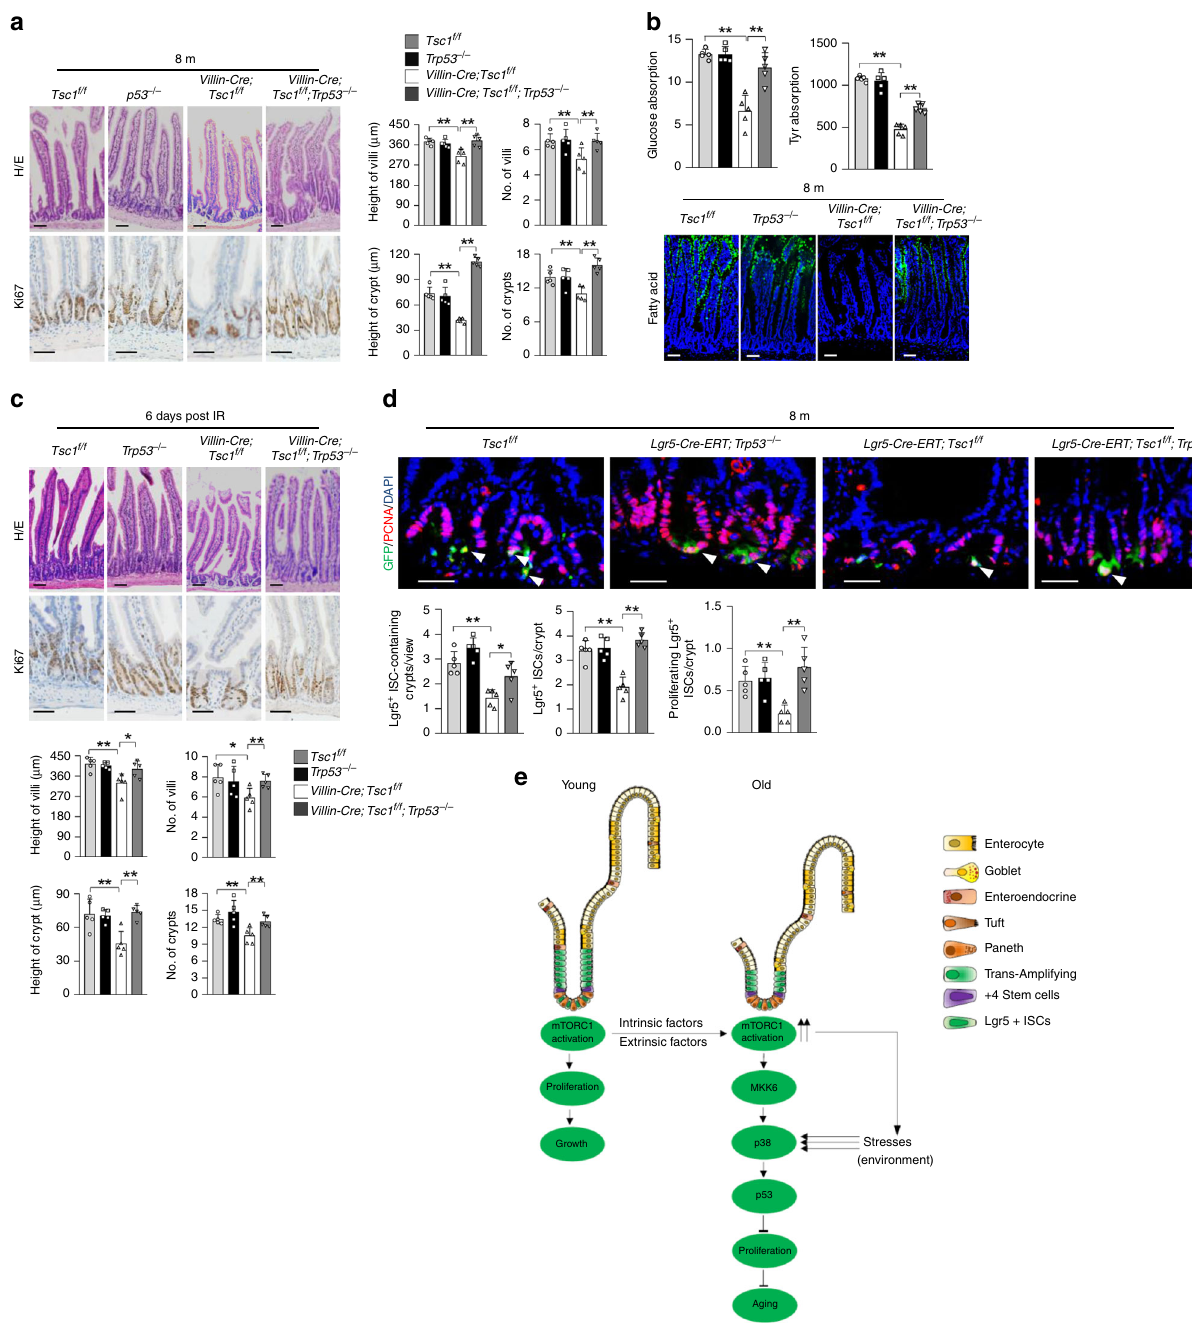
Fig. 7 Ablation of Trp53 prevents mTORC1-driven villus aging. a – c Deletion of Trp53 rescued the deterioration in villus and crypt structures ( a ), decreased nutrient absorption activities ( b ), and compromised regeneration ( c ) in 8-month-old Villin-Cre;Tsc1 f/f mice. Data are expressed as mean ± SEM. N = 5 mice per group. * P < 0.05, ** P < 0.0 (determined using Student ’ s t test). d Trp53 ablation rescued the decrease in the numbers of ISCs and proliferating ISCs in 8-month-old Lgr5-GFP-CreERT;Tsc1 f/f mice. The intestinal sections were immunostained for PCNA, and cells positive for PCNA and GFP were counted and normalized to the total numbers of Lgr5 + ISCs. Bottom panels: quanti fi cation data (mean ± SEM). N = 5 mice per group. * P < 0.05, ** P < 0.0 (determined using Student ’ s t test). e A model for controlling gut stem and progenitor cell aging by mTORC1. Lgr5 + ISC-containing crypts, Lgr5 + ISCs per crypt, and pro- liferating Lgr5 + ISCs as well (Fig. 7d). These results indicate that